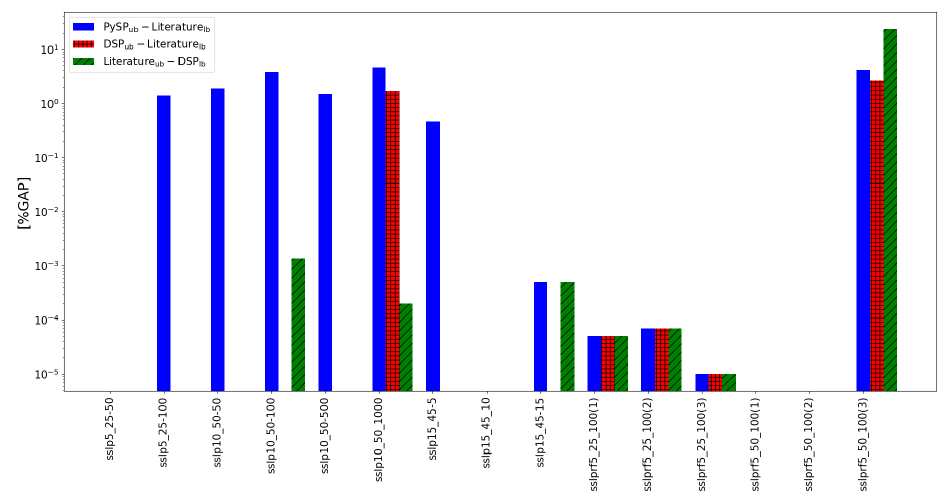
Figure 4. Comparison of optimality gaps from PySP, DSP, and literature for SSLP and SSLPR library— instances with only binary in the first stage.